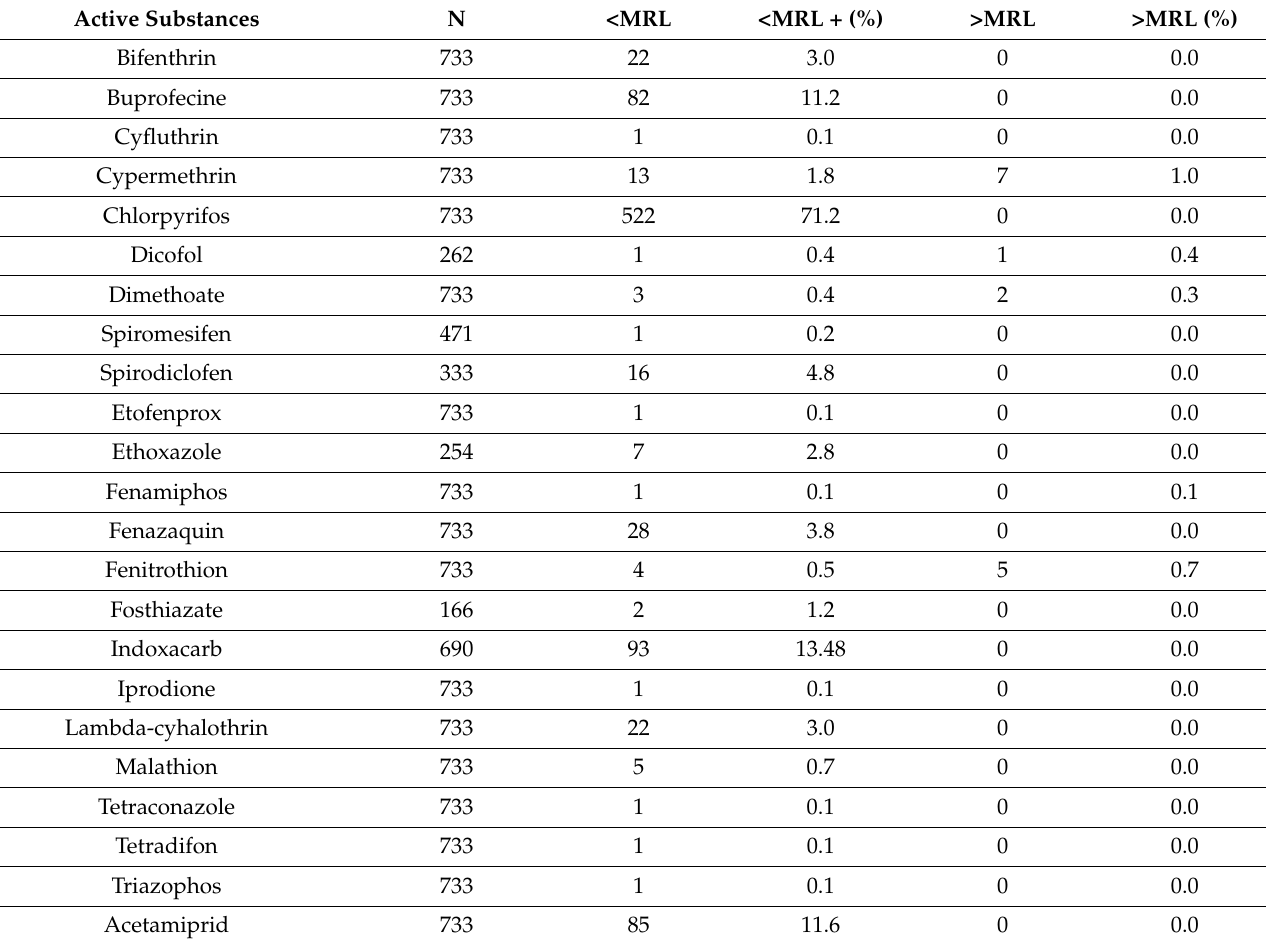
Table 7. Active substances of which residues were detected. 2008–2017; (N: no. of samples; <MRL: no. of residues > LDA < MRL; >MRL: no. of residues >